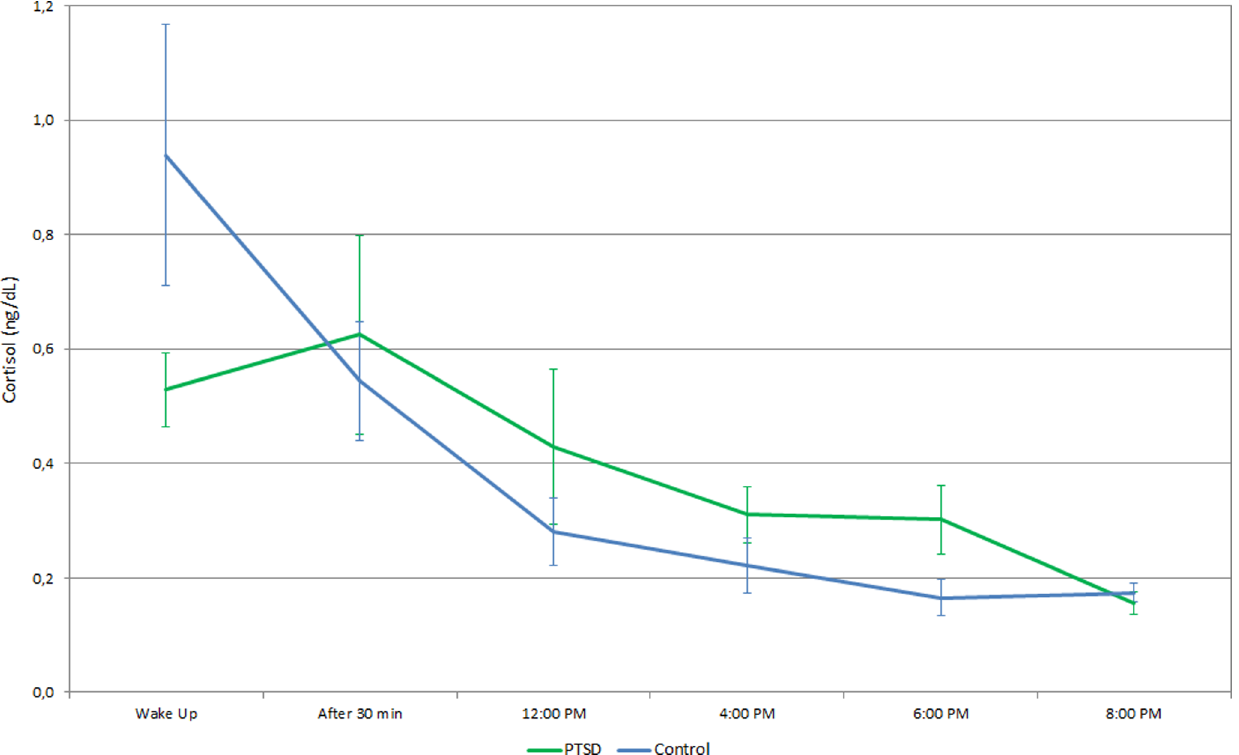
Figure 3. Cortisol. Distribution of mean cortisol values throughout the day in cases of PTSD and controls.